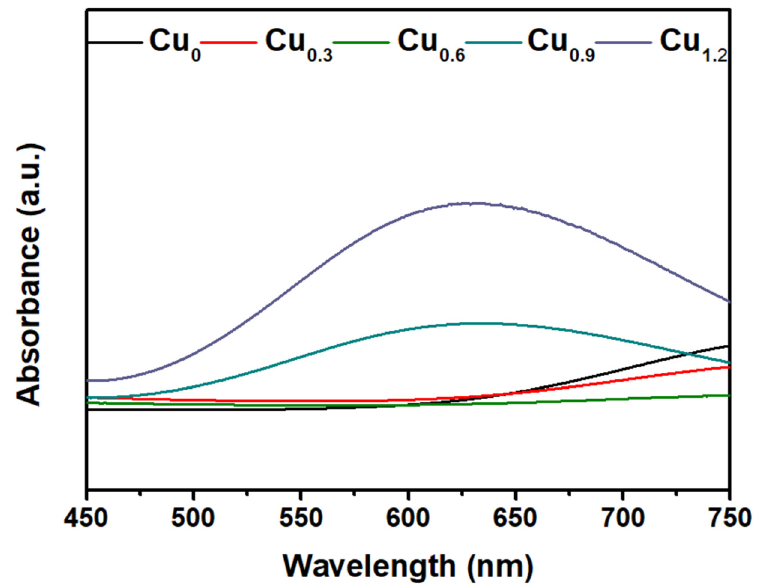
Figure 4. UV-vis absorption spectra of precursor solutions for Cu 0 , Cu 0.3 , Cu 0.6 , Cu 0.9 , and Cu 1.2 .